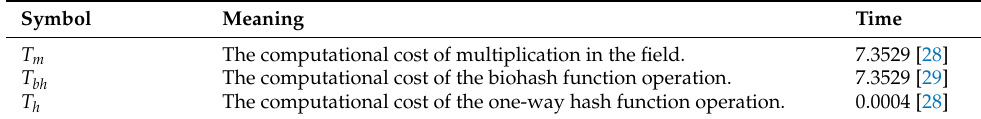
Table 12. Computational cost of cryptographic calculations